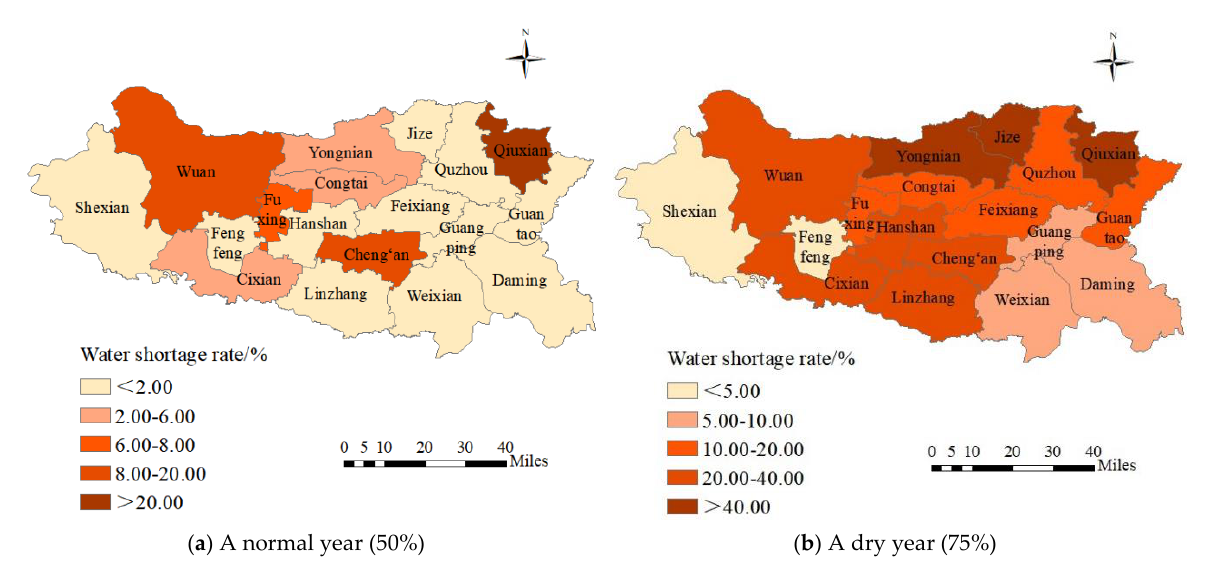
Figure 12. Water shortage rate in 2035.